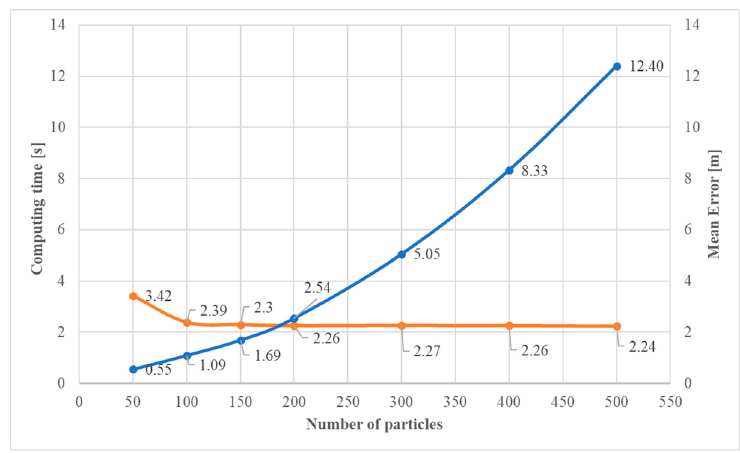
Figure 16. Mean positioning error and overall computation time for different particles of the map-aided PF algorithm.